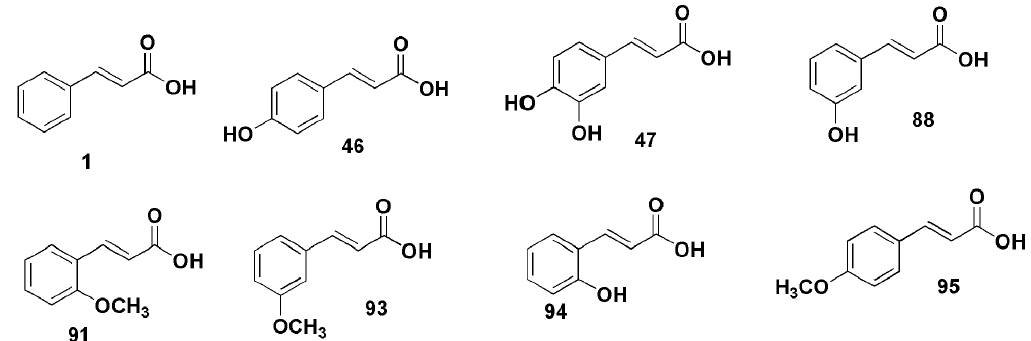
Figure 30. Chemical structures of compounds 1, 46, 47, 88, 91 and 93-95 [81]. The methoxy group, OCH 3 is an electron donor and it increased the charge on the benzene ring making the inhibition constant to be in the order 95 ˃ 93 ˃ 91 ˃ 1 . Tyrosinase could not hydroxylate compound 94 but was able to hydroxylate compound 88 because compound 94 has a great distance for ligand hydroxylation while compound 88 has a distance feasible for hydroxylation [81].